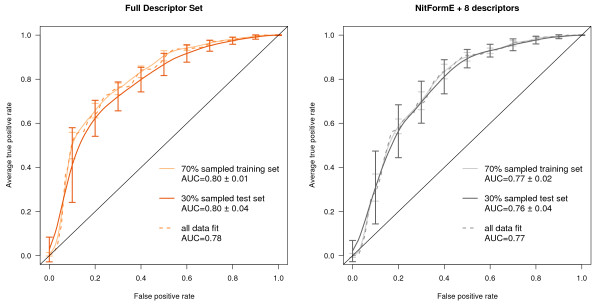
Averaged ROC curves for Set B aryl-amine PLS models. The plot on the left uses a full descriptor set while the plot on the right is for a model using a limited descriptor set. The left plot shows the averaged (identical false positive values) ROC curves for the test (dark line) and training (lighter line) sets of 100 PLS models built on a random 70% sample of the Set B aryl-amine data (MW < 250 g/mol) and the performance of a PLS model built on all of the data as a dashed line with all non-zero-variance descriptors. The right plot uses only 9 descriptors including nitrenium formation energy.